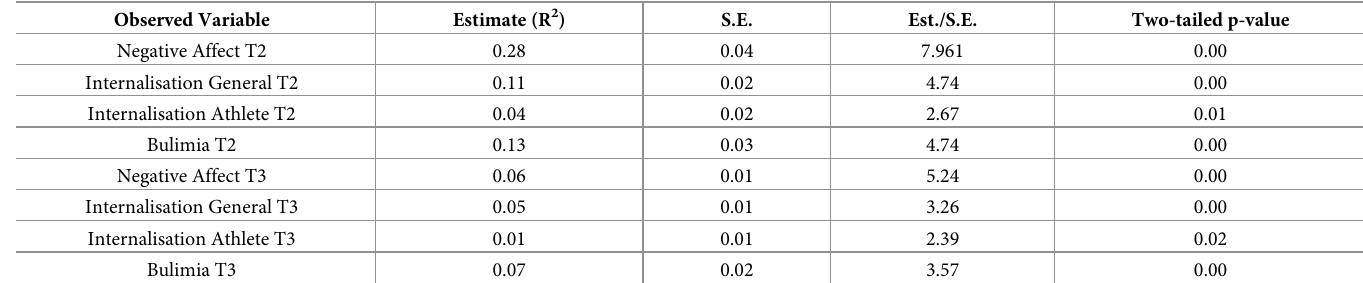
and response code (via scalar invariance) are understood the same way across time for all sports/genders (see Table 8). Using chi square of difference testing it was found that all scales had metric and scalar invariance for lean vs nonlean and gender apart from gender invariance for the Bulimia